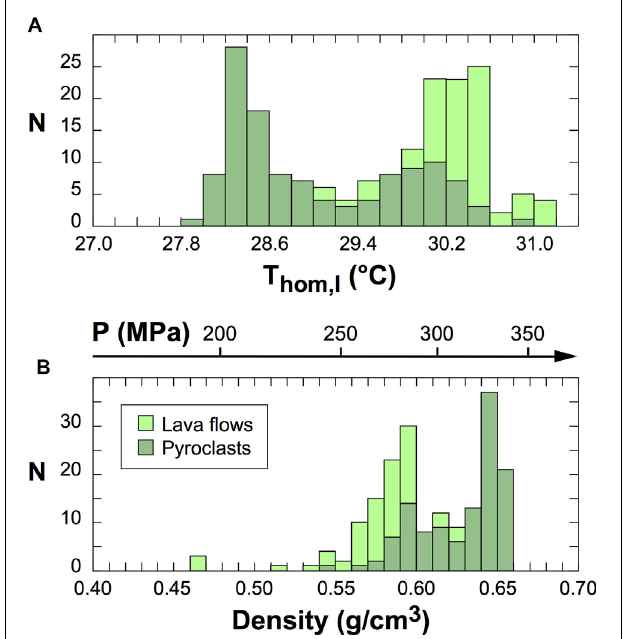
FIGURE 8 | Frequency distribution of (A) homogenization temperatures and (B) densities of clinopyroxene-hosted fluid inclusions as determined by microthermometry. Inclusions from quenched glassy lapilli (sample SD04) have higher densities than those from lava flow samples, indicating continuing re-equilibration during the time the samples resided in the flowing